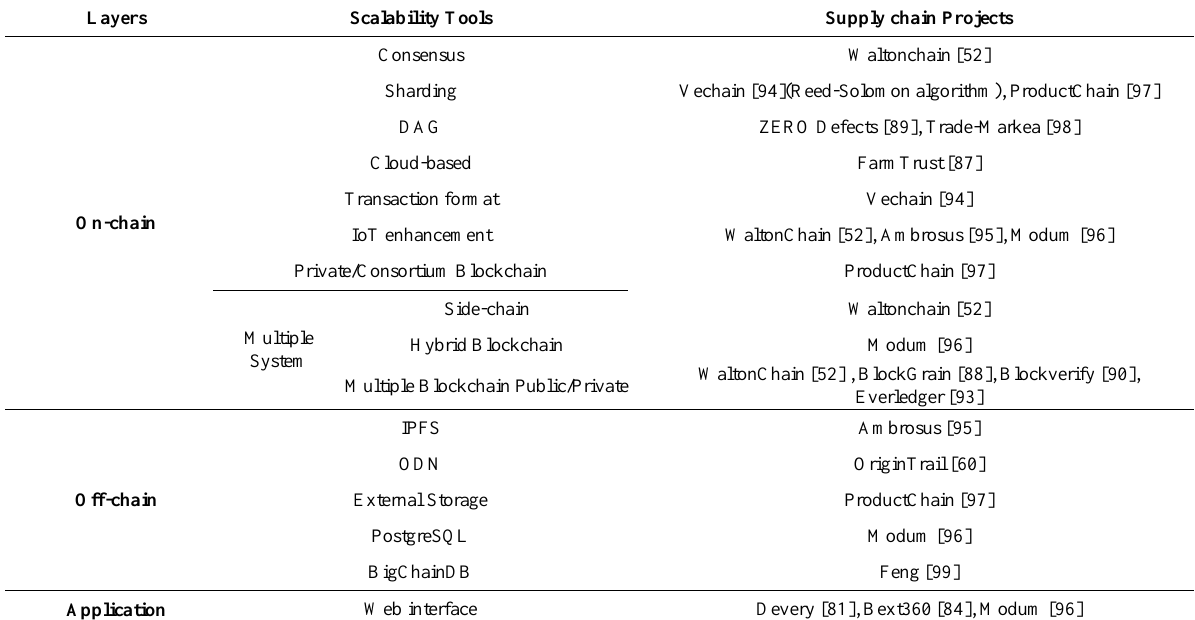
Table 5. Taxonomy of the supply chain DLT